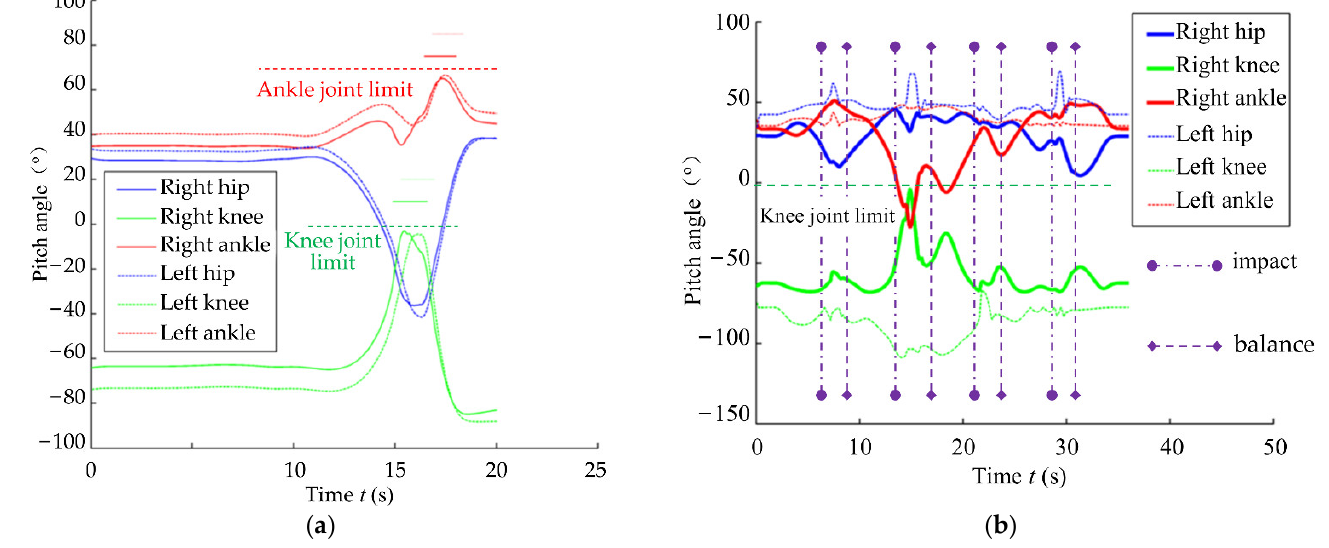
Screenshots of the single-stance stability verification simulation with impact using Figure 12. Pitch angles from two single-leg stance simulations. ( a ) Without impact; ( b ) with impact. the virtual prototype in Adams are shown in Figure 13.